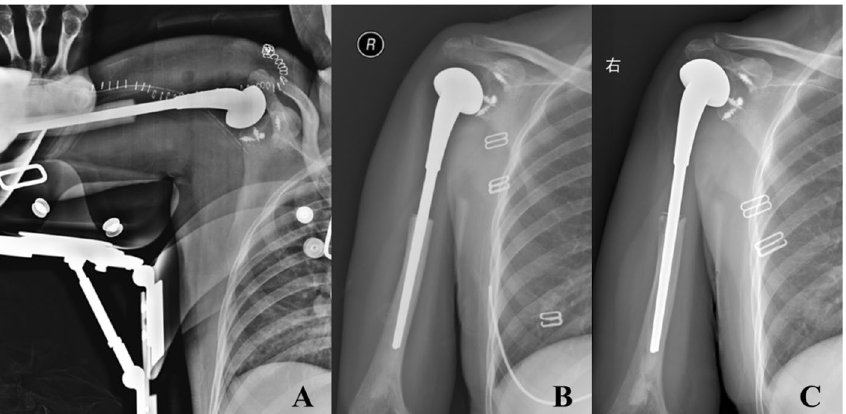
Figure 3. The postoperative radiography ( A ) showed 4 anchors were fixed in different directions (upper, lower, front and back) of the glenoid to restore the stability of the prosthesis. The radiography 3 months postoperative ( B ) and the radiography 104 months postoperative ( C ) showed the prosthesis was in stable position without obvious loosening and dislocation.